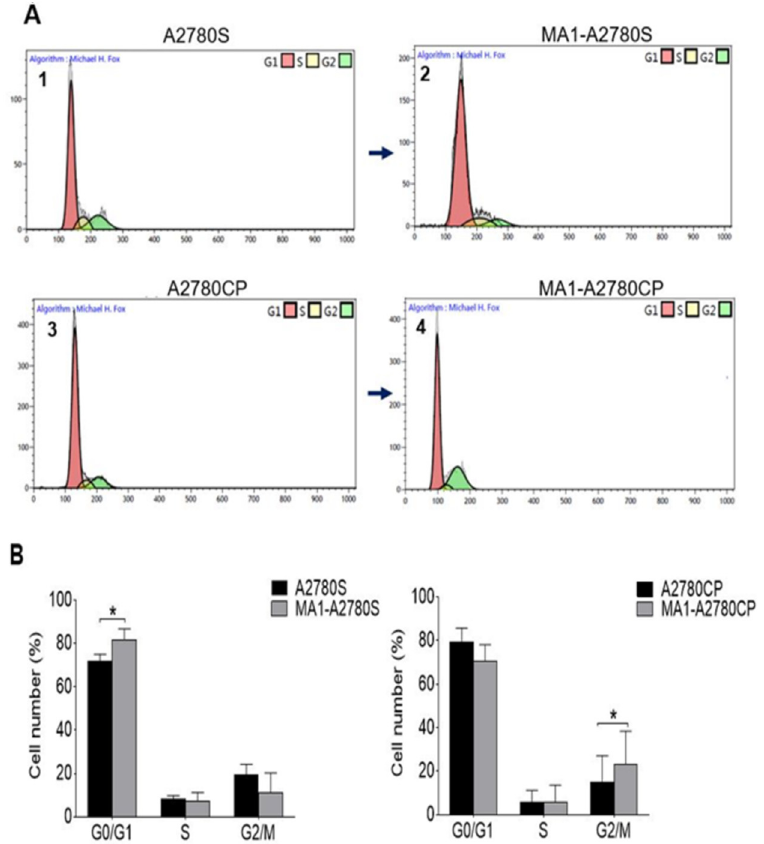
Figure 5. ( A ) Cell cycle analysis by flow cytometry based on propidium-iodide intercalation into the cellular chromatin. Data are presented as a relative fluorescence intensity in a 2-dimensional flow cytometry profile; ( 1 ) and ( 3 ) were untreated samples versus ( 2 ) and ( 4 ) treated samples for 24 h. ( B ) Comprehensive bar diagram of subpopulations of G0/G1, S, and G2/M. Ten thousand events were analyzed for each sample. Data represent the mean ± SE of three experiments at each concentration. * p < 0.05.